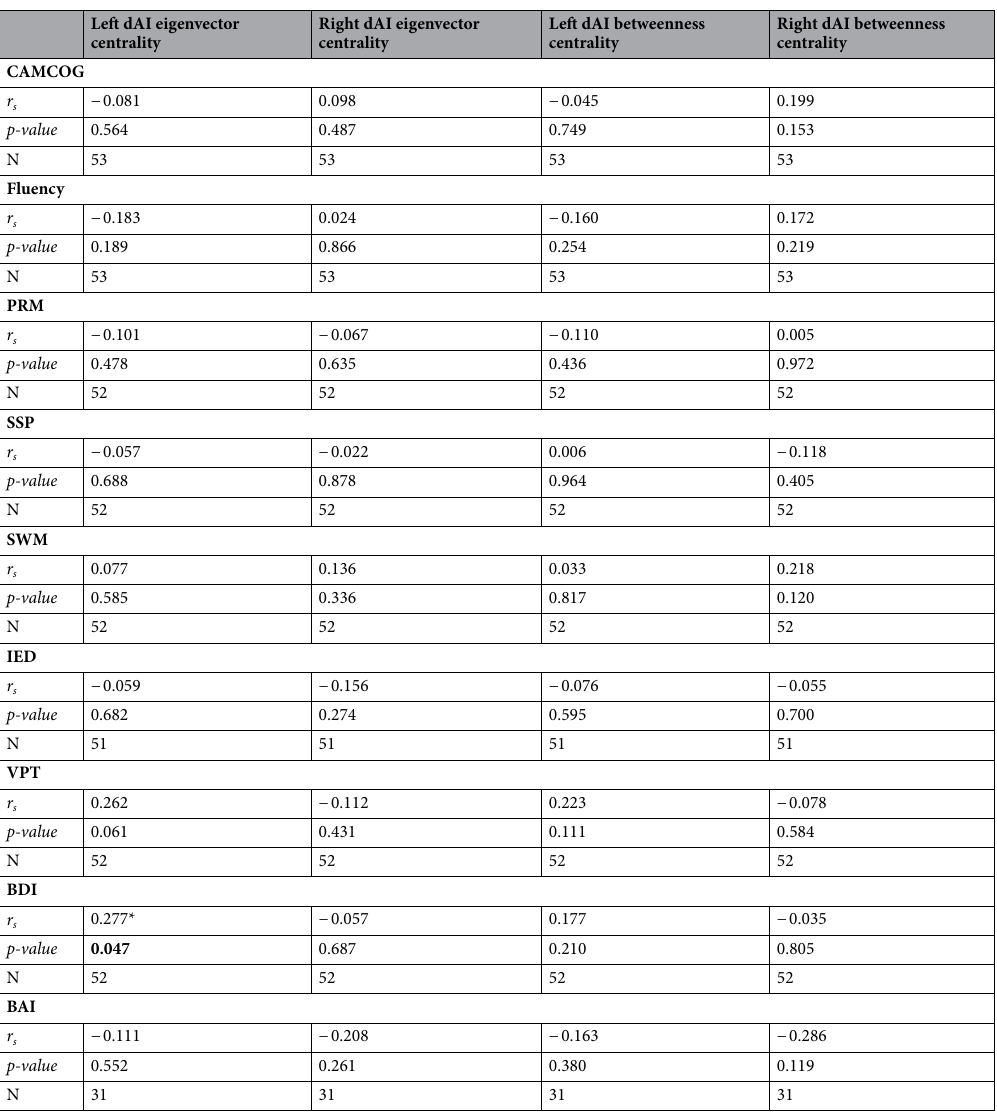
Table 2. Associations between centrality measures and cognitive and affective measures in PD. r s = Spearman correlation; vAI = ventral anterior insula; dAI = dorsal anterior insula. CAMCOG = Cambridge Cognitive Examination revised test battery; PRM = pattern recognition memory; SSP = spatial span; SWM = spatial working memory; IED = the intra-extra dimensional set shift test; VPT = Vienna perseveration test; BAI = Beck Anxiety Inventory; BDI = the Beck Depression Inventory. * p <